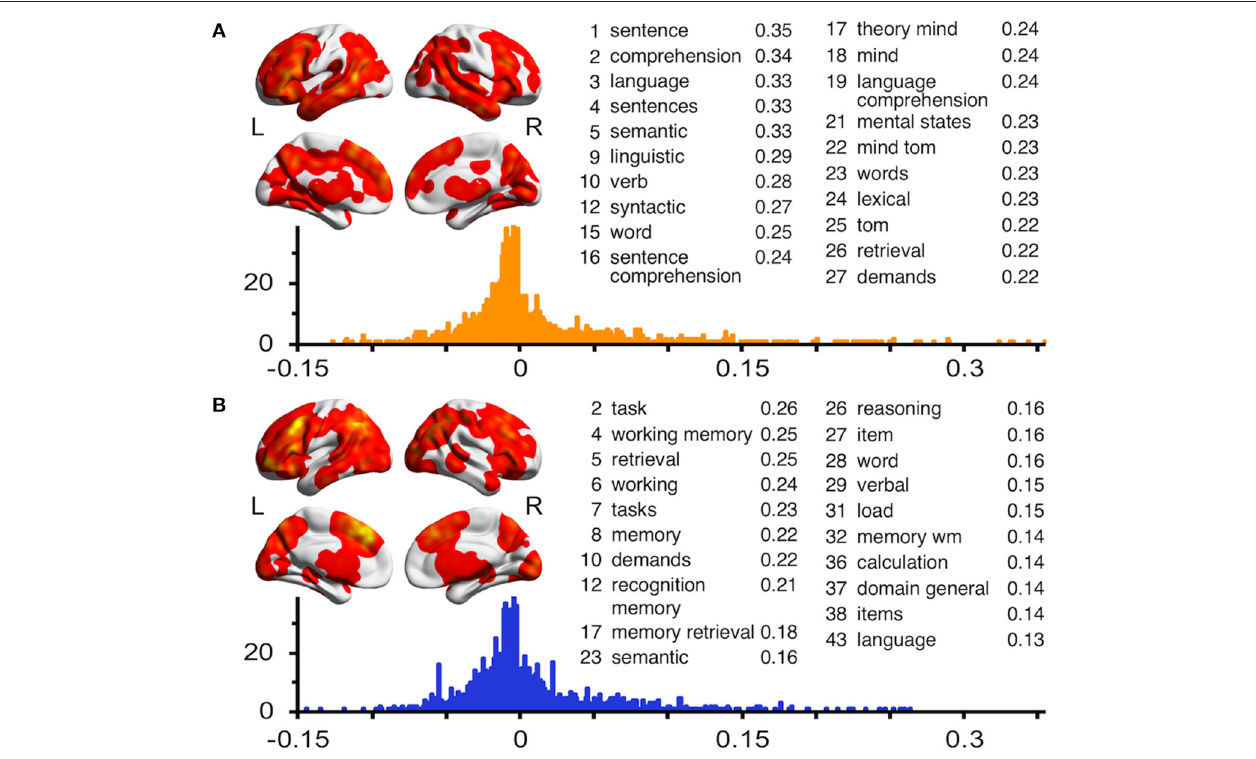
FIGURE 3 | Results of neural pattern similarity analyses using the ALE map of discourse inferences (A) and logical inferences (B) . The unthresholded ALE maps are visualized on a surface rendering of the smoothed ICBM152 template. The histograms represent the frequency distributions of the Pearson’s r between the ALE map and the z map for each term in the Neurosynth database. For each ALE map, the embedded table lists the most highly correlated cognitive or psychological terms ranked by r values. Terms associated with brain regions are not included in these